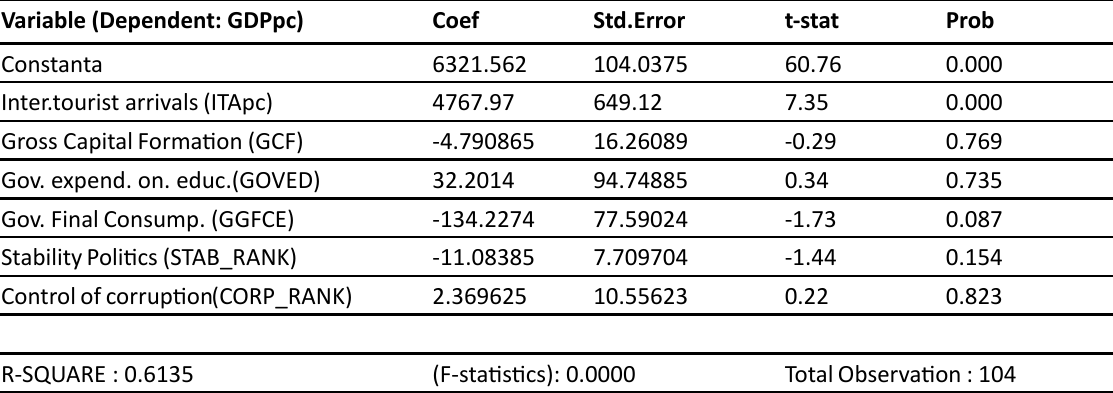
Table 4: Estimation Results Fixed Effects Model (FEM) with the Weighted Method and With - in Group Estimator Model